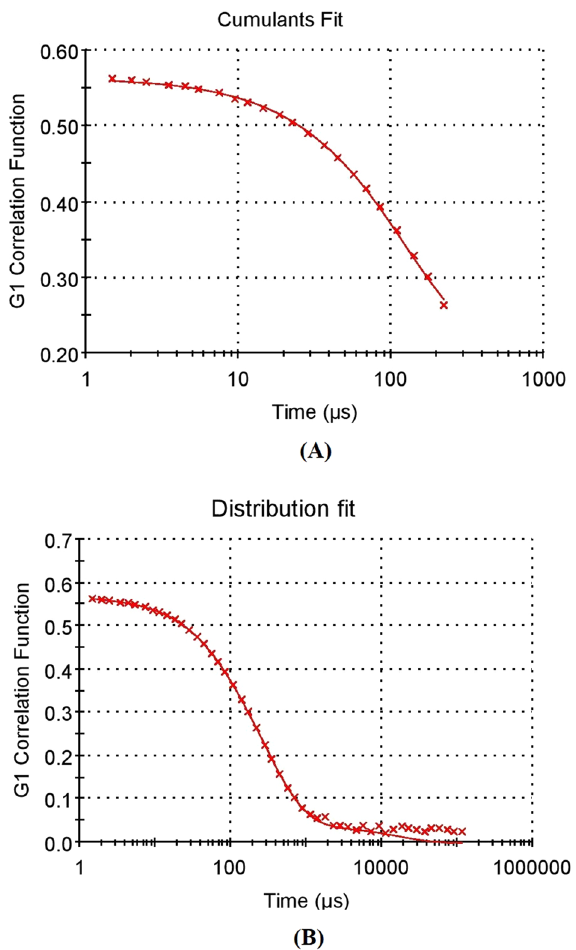
Figure 3. Physical characterization of 1% w/v of dextran sulfate sodium (DSS) nanoparticles of batch 3. ( A ) Cumulative fit analysis of DSS nanoparticle. ( B ) Size distribution fit analysis of DSS